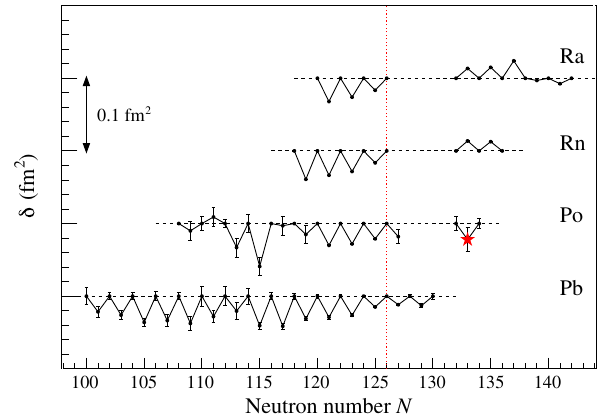
FIG. 12. Relative odd-even staggering δ in the δ h r 2 i of 82 Pb [14,70 – 72], 84 Po [16,58,60], 86 Rn [64,73], and 88 Ra [66,73] [see Eq. (1)]. Error bars from the original δ h r 2 i are shown for each point. The vertical offset between each chain is artificial for better display. The vertical line at N ¼ 126 marks the neutron-shell closure. For 217 Po 133 , only the solution for I ¼ 9 = 2 is shown, highlighted by the red